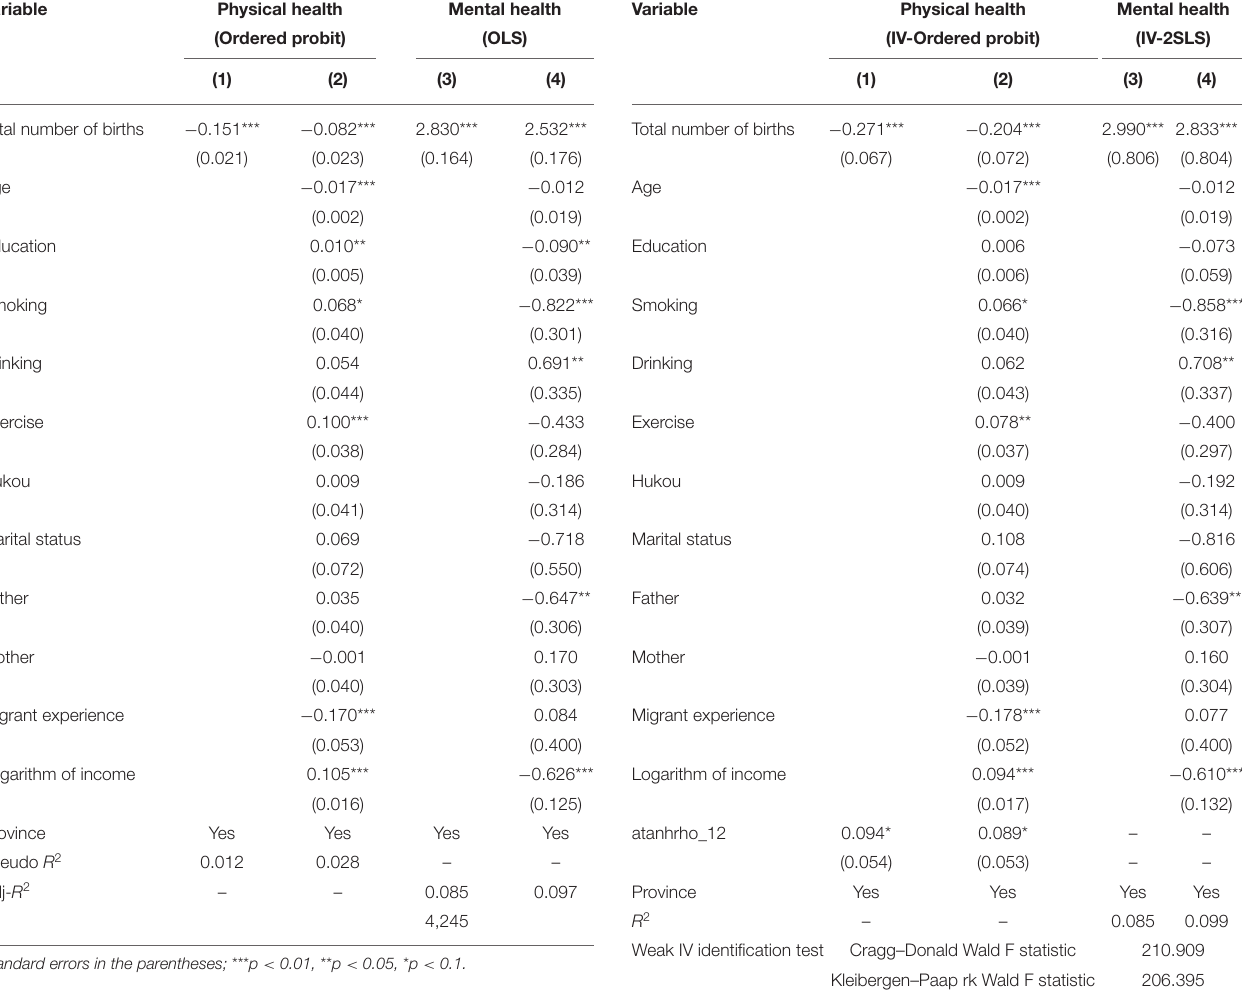
TABLE 2 | Effects of fertility on physical and mental health of women of childbearing age. Variable